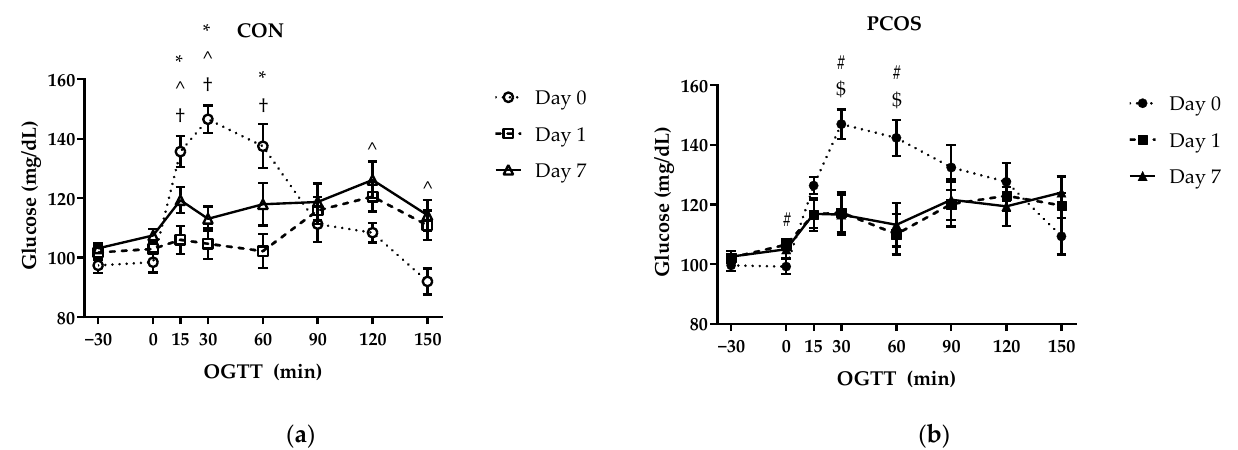
Figure 2. Mean (± SE) glucose concentrations in ( a ) CON ( n = 15) and ( b ) PCOS ( n = 14) across timepoints. * = significance between Day 0 and Day 1 for CON; ˆ = significance between Day 0 and Day 7 for CON; † = significance between Day 1 and Day 7 for CON; # = significance between Day 0 and Day 1 for PCOS; $ = significance between Day 0 and Day 7 for PCOS, p < 0.05. CON = non-PCOS women; OGTT = oral glycemic tolerance test; PCOS = women with polycystic ovarian syndrome.